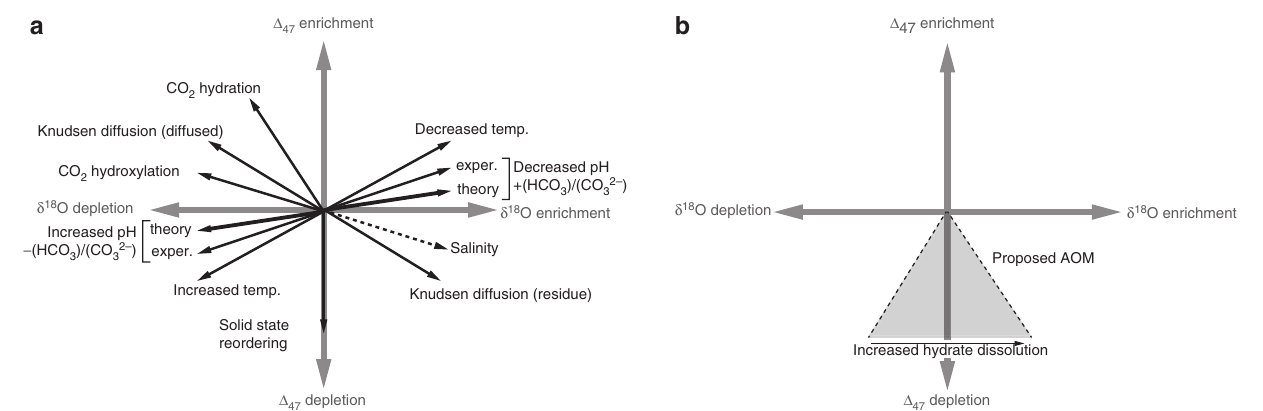
Figure 6 | Various controls on D 47 values. ( a ) In addition to temperature 20 , diffusion, salinity, pH and CO 2 hydration/hydroxylation reactions have been shown to influence the clumped isotope compositions of carbonates 40,41,45,46,49,52 . CO 2 hydroxylation and hydration are pH sensitive, with hydroxylation favored at higher pH 46 . Solid-state re-ordering may also impact carbonates, with increased rates at higher temperatures and greater potential for re- ordering in older rocks 22,70 . Mixing has been shown to produce variability in multiple trajectories 19 . Increased salinity produces d 18 O enrichment and D 47 depletion, however the specific slope can vary. ( b ) Hypothesized influences by AOM reactions and